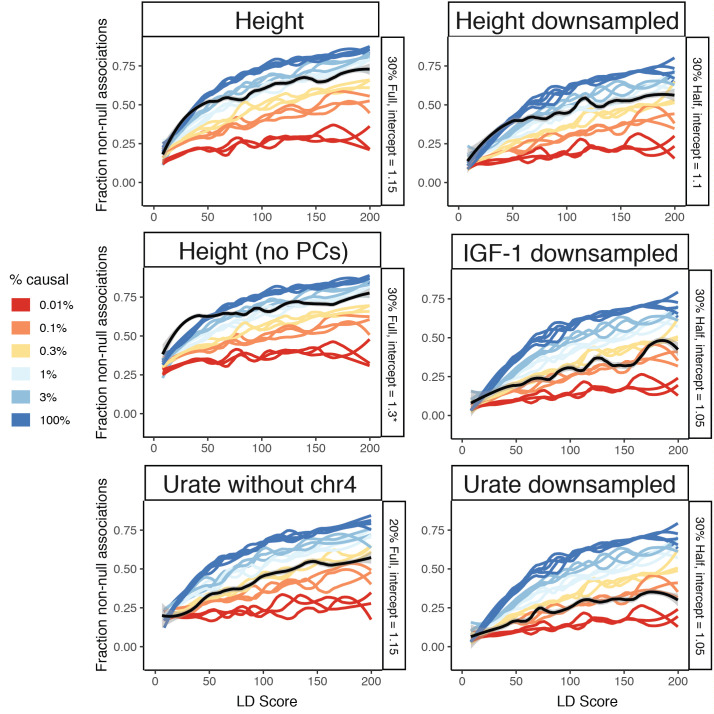
Additional traits to fit causal simulations on.Height, height without principal components regressed out of the GWAS, Urate with chromosome four excluded (where both SLC2A9 and ABCG2 are located, reducing SNP-based heritability to ≈20%), and random 50% downsamplings of height, IGF-1, and urate (including chromosome 4) are shown. See Figure 8—figure supplement 3 for additional sex hormone traits. Despite matching simulations for sample size, slight reductions in causal variant count are still observed in downsampled traits, suggesting that power is still possibly limiting, of particular relevance to the sex-stratified testosterone GWAS. As expected, excluding principal components from the GWAS dramatically increases the intercept. * 1.3 was the highest tested intercept and is still too low, but no more runs were completed as the curve is clearly shaped very differently than simulation runs regardless of intercept. We recommend performing GWAS while regressing out principal components to avoid difficult to interpret results. See Figure 8—figure supplement 3 for additional fits to sex hormone related traits.